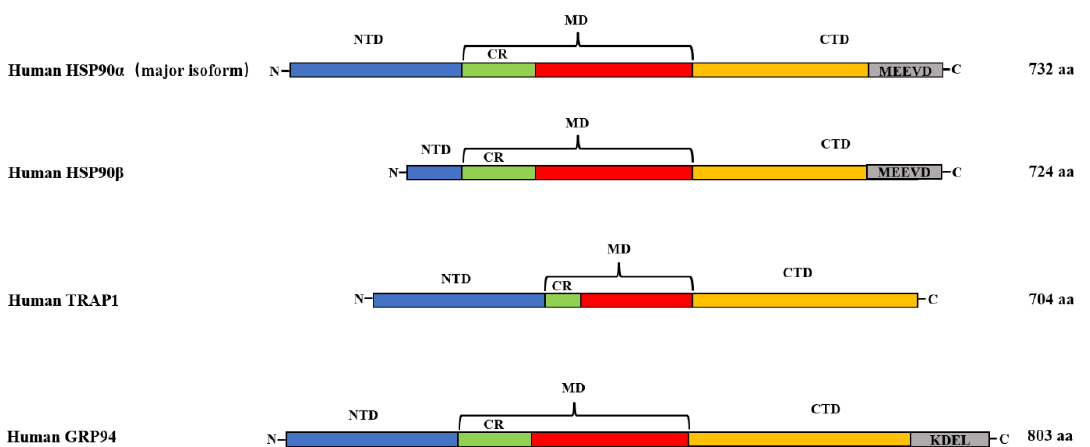
Figure 1. Diversity of protein domains of human HSP90 family members. HSP90 α and HSP90 β are mainly in the cytoplasm, TRAP1 is mainly in the mitochondrial matrix, and GRP94 is mainly in the ER; HSP90 α , HSP90 β , GRP94, and TRAP1 are, respectively, 732, 724, 803, and 704 amino acids in length. Their overall molecular structure includes three major conserved domains: NTD (ATPase, co-chaperone binding), MD (client protein binding, co-chaperone binding, ATPase activation), and CTD (dimerization, co-chaperone binding, client protein binding). CR in the above figure represents charged flexible linker.